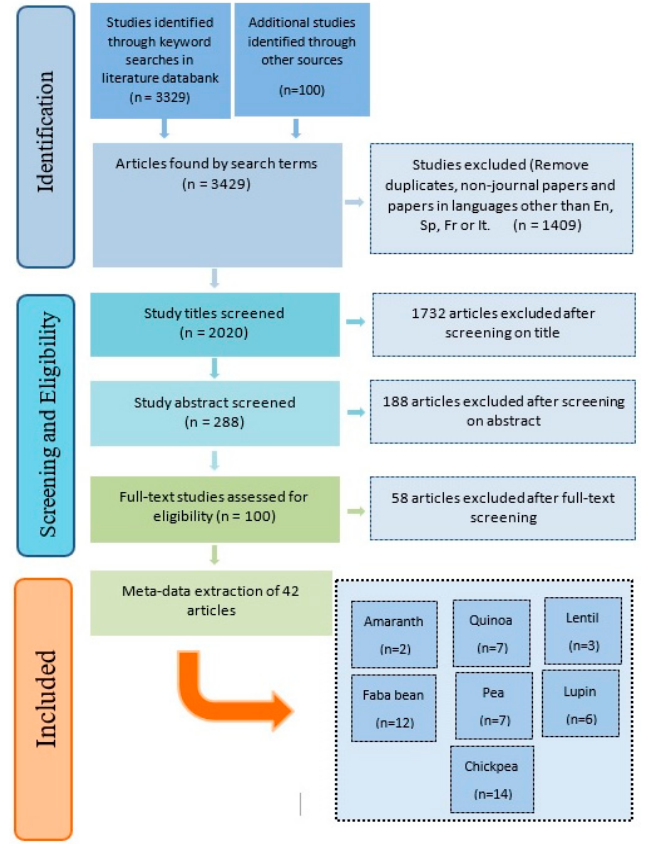
Figure 2. Selection of studies for inclusion in the systematic review (n represent the number of studies).